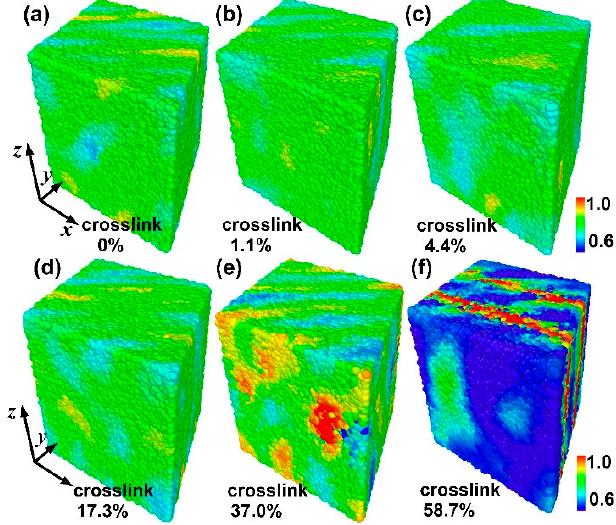
Figure 8. The three ‐ dimensional atomic strain distribution for different crosslink densities under shear (=50%) at T = 0.1. ( a ) Linear polymer; ( b ) 1.1% crosslink density; ( c ) 4.4% crosslink density; ( d ) 17.3% crosslink density; ( e ) 37% crosslink density; and ( f ) 58.7% crosslink density.